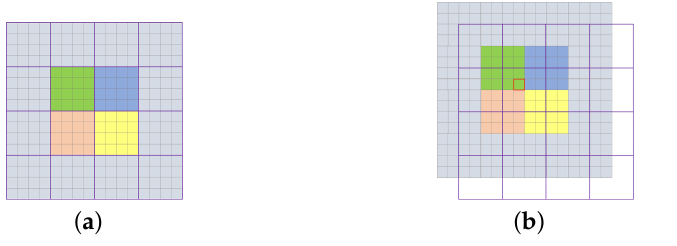
Figure 5. Self-attention in windows portioning ( a ) and Shift windows partitioning ( b ) operation. The orange, yellow, green and blue colors represent Tokens in each window in ( a ), the red boxed pixel in ( b ) can be used to perform a self-attention operation with the four adjacent pixels in the previous windows